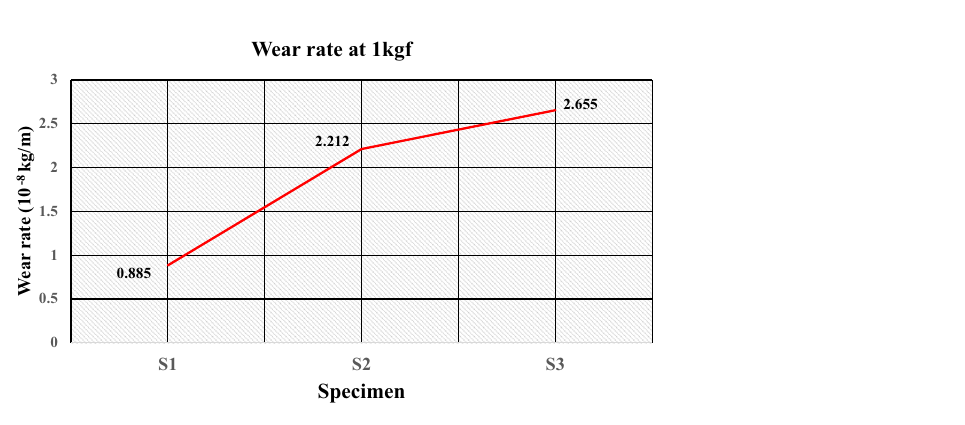
Figure 23. Wear rate of the specimens at 1